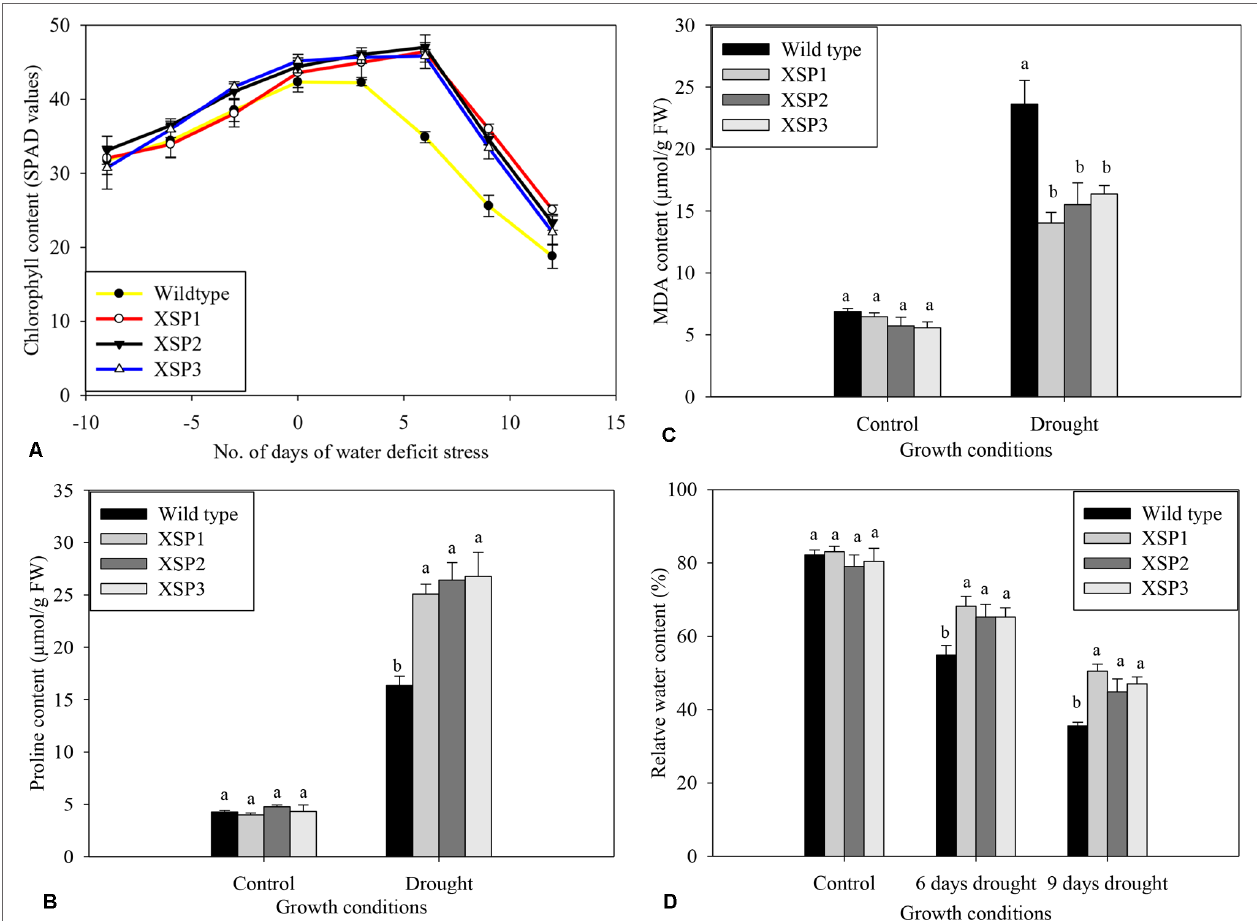
FIGURE 5 | Biochemical index changes of wild type and XvSap1 transgenic sweet potato plants under control and drought stress conditions. (A) Chlorophyll content. (B) Proline content. (C) Malondialdehyde content. (D) Water content. Means ± SE (standard error) followed by different alphabets in each growth condition are significantly different ( P ≤ 0.05 ) using Fisher’s least significant difference (LSD). Data are from three independent replicates of the same event ( Table S10−S13